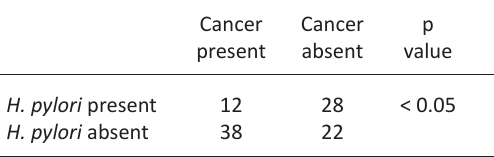
Table 5. H pylori infection in cases vs